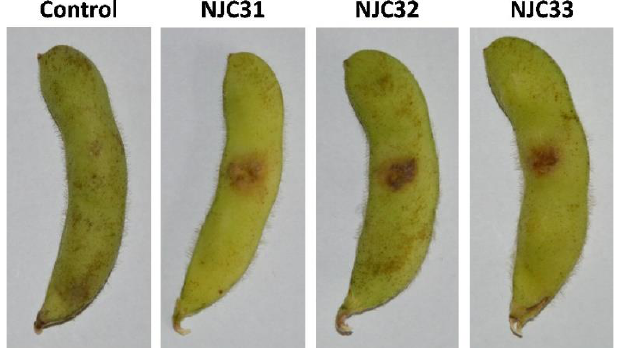
Figure 4. Pathogenicity assay of Fusarium sulawense strains NJC31, NJC32 and NJC33. A 0.5 cm 2 size wound was cut in each soybean pod and the pathogens were inoculated using a 1 × 10 6